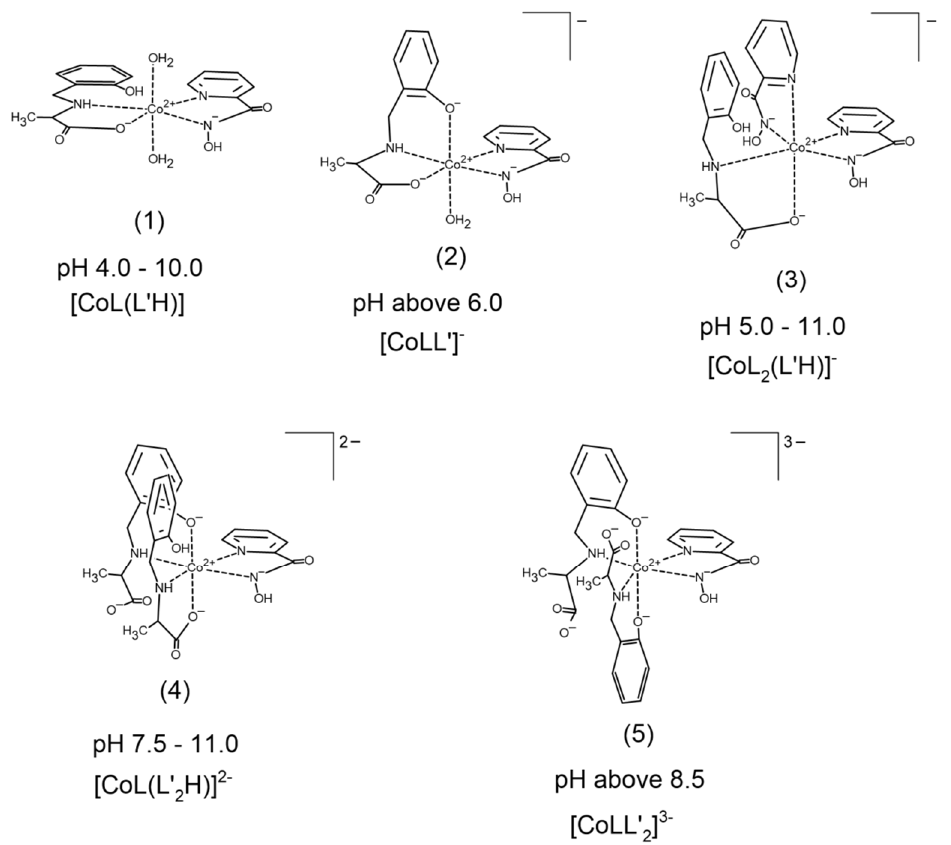
Figure 3. Proposal for pH-dependent coordination of complexes formed in the Co(II)–PicHA–AlaSal system.